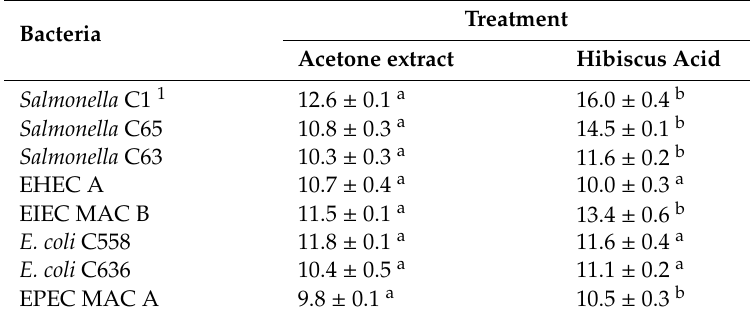
Table 5. Zone of inhibition diameter of Hibiscus sabdari ff a calyx acetonic extract and hibiscus acid against multidrug-resistant Salmonella and pathogenic Escherichia coli